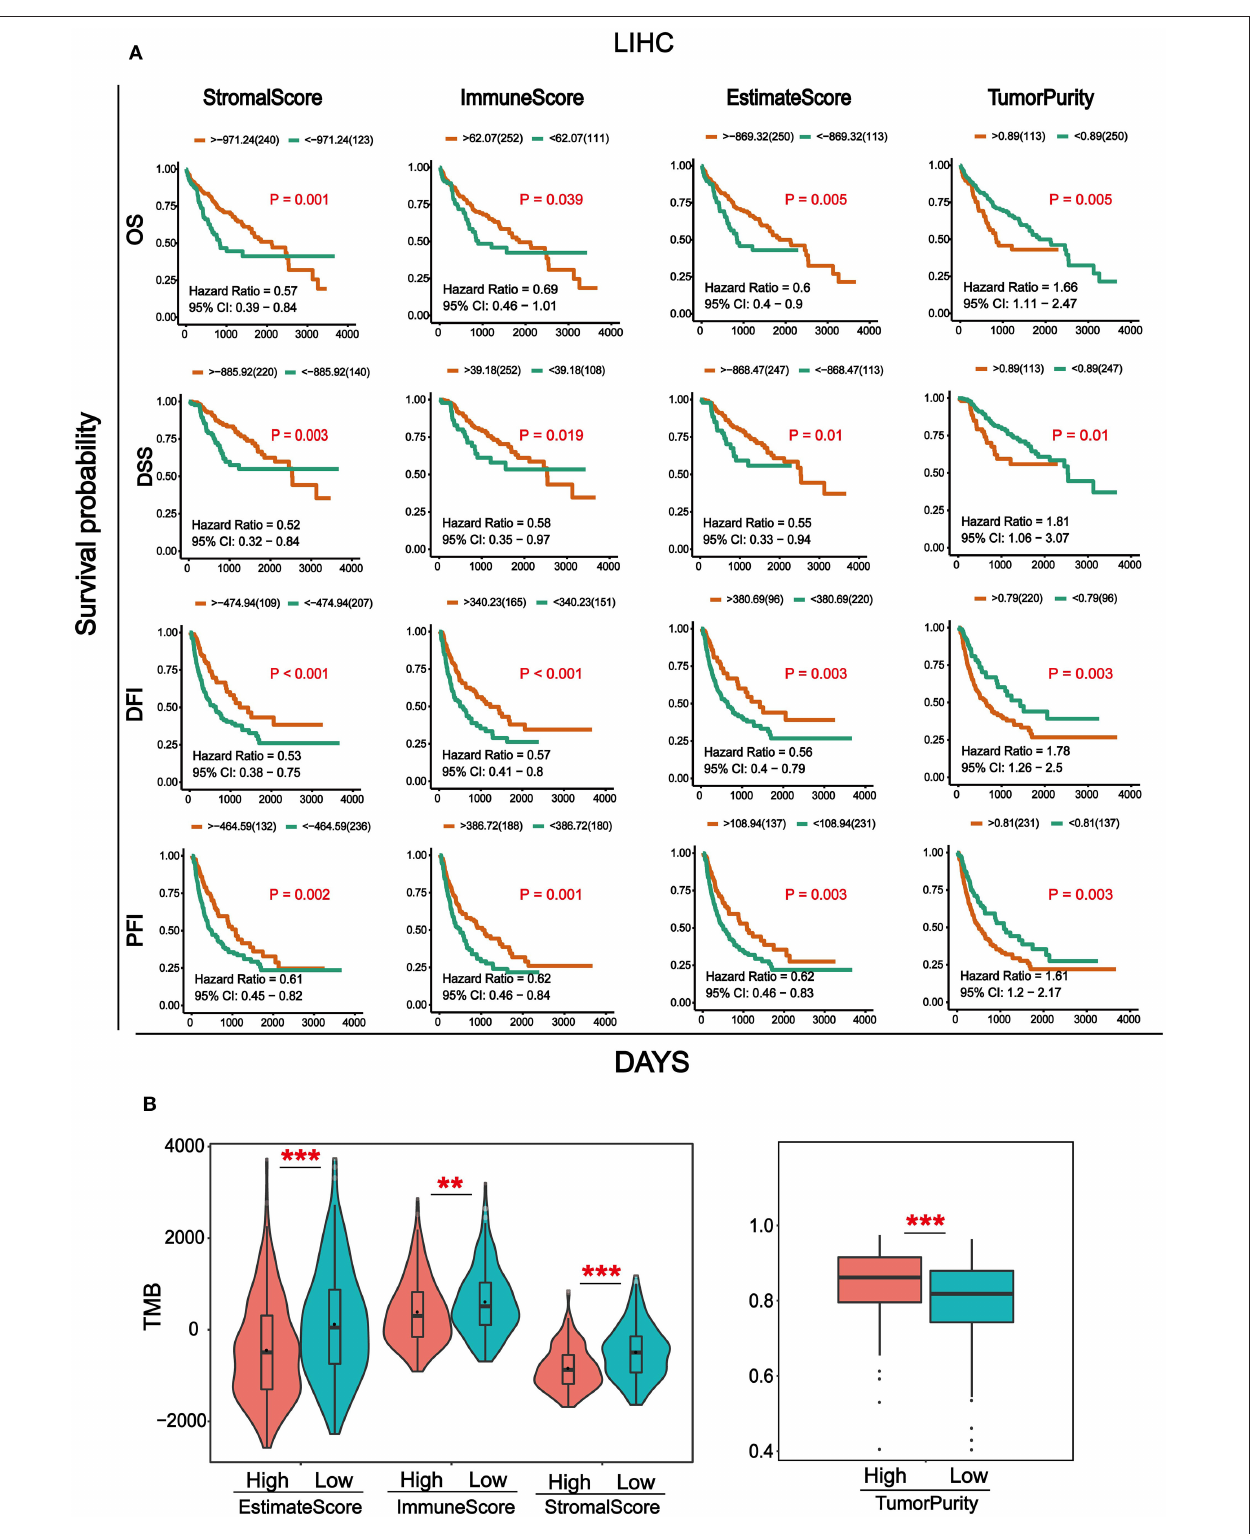
FIGURE 1 | Analysis of survival and Tumor mutation burden (TMB) associated with immune/stromal/Estimate scores and tumor purity. (A) Kaplan–Meier survival analysis based on immune/stromal/Estimate/scores and tumor purity. Overall survival (OS), disease-specific survival (DSS), disease-free interval (DFI), progression-free interval (PFI). (B) The relationship of immune/stromal/Estimate/scores and tumor purity with tumor mutation burden (TMB). The samples were divided into high and low groups according to the median of score. * p < 0.05, ** p < 0.01, and *** p < 0.001 between the two groups.